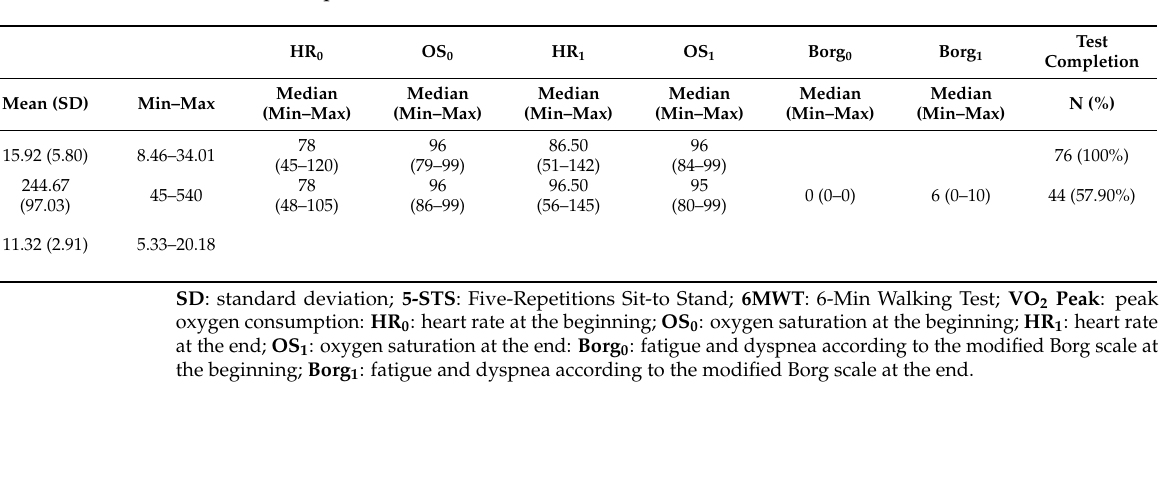
Table 1. Descriptive statistics of the functional tests ( n =